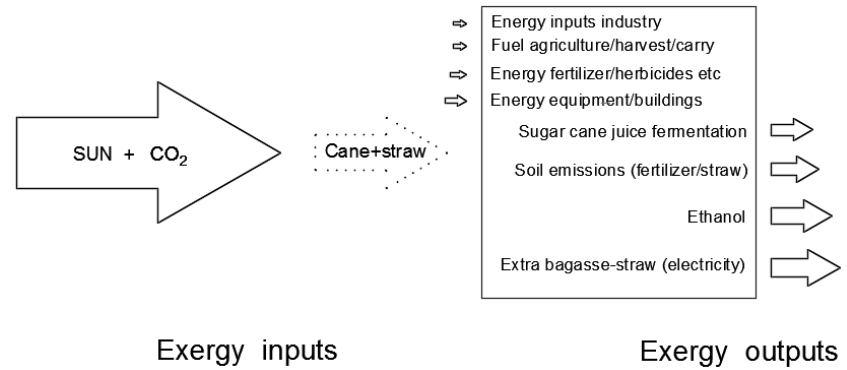
Figure 3. Exergy flows in the sucroenergy sector (arrows represent proportionality values, except that with the caption, “SUN”).